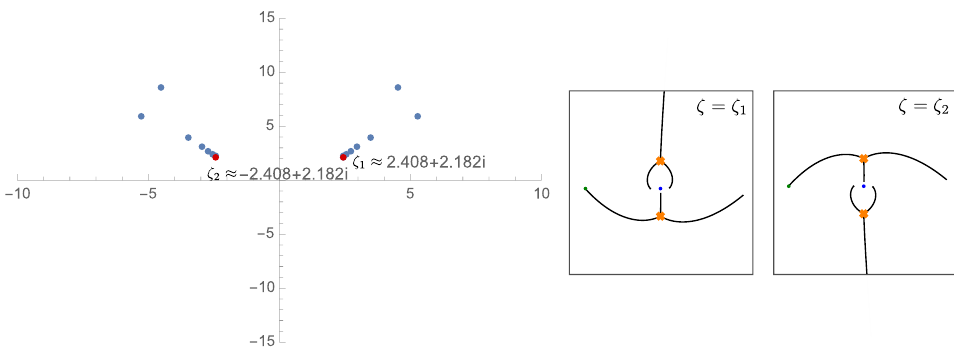
Figure 16 . Left: singularities of the Padé-Borel transform of the Y (2) in (3.7) for the operator (C.5). We take u = 0 , z = e x = − e and use N = 40 terms in the series. The leading singularities ζ , i marked in red, match well with (3.23); thus as expected they are the central charges of BPS solitons on the surface defect with parameter z . (For Y (1) the singularities would be at the opposite points ζ = − ζ i .) Right: for fixed ζ = ζ i we plot a cutoff version of the Stokes graphs with ϑ = arg( ζ ) , plotting the Stokes curves only up to | 2 R z λ | = | ζ | . As explained around (3.23), the cutoff Stokes z 0 curves W ϑ =arg( ζ i ) run exactly up to the point z = − e , which is plotted as a green